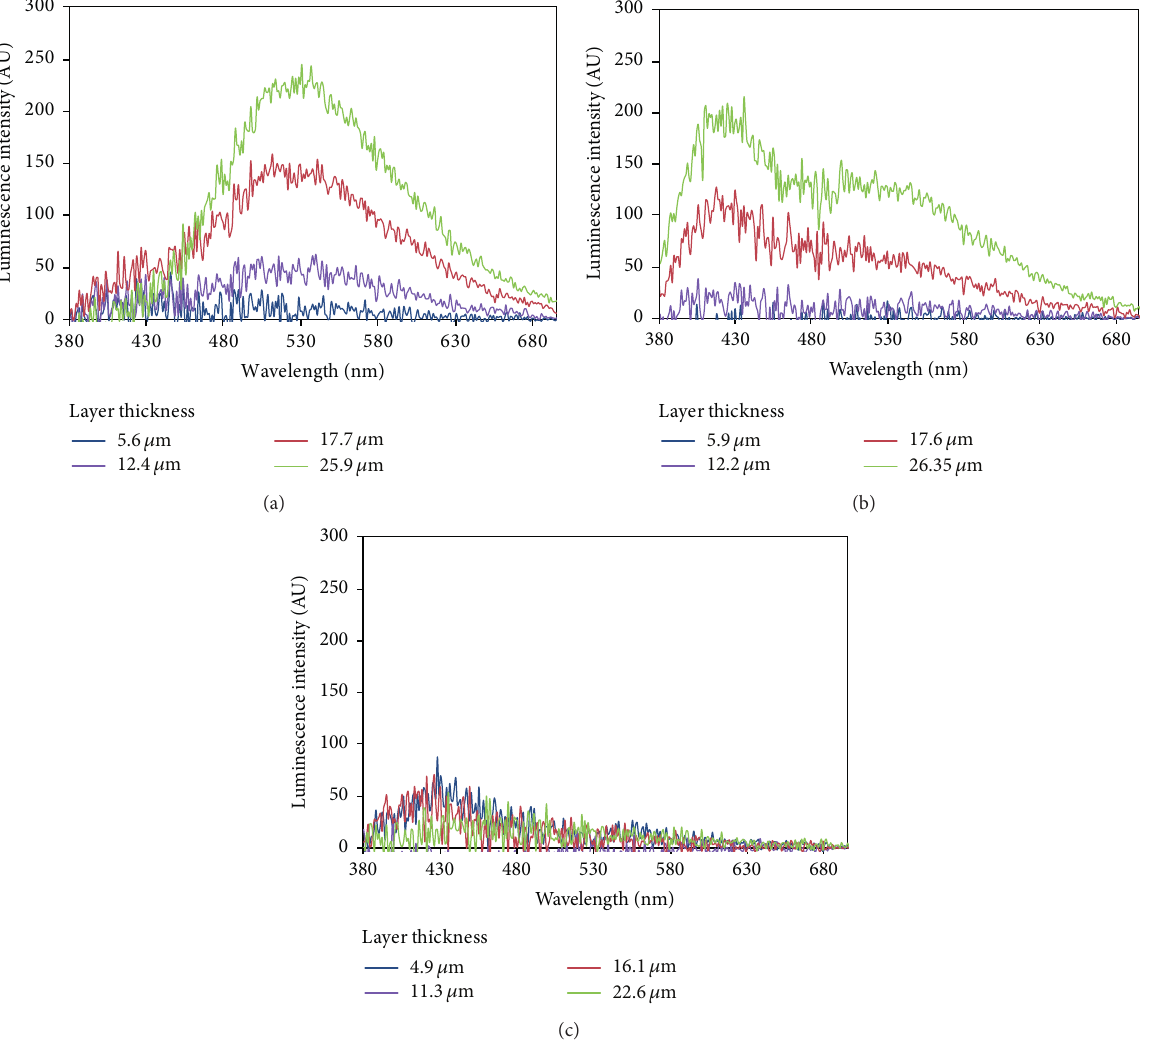
Figure 11: The own luminescence spectra of images printed onto the paper with the maximum content of OBAs (paper 3) using the ink compositions with the following contents of the fluorescent component (ZnO nanoparticles): (a) 0.15%; (b) 0.1%; (c) 0.05%.